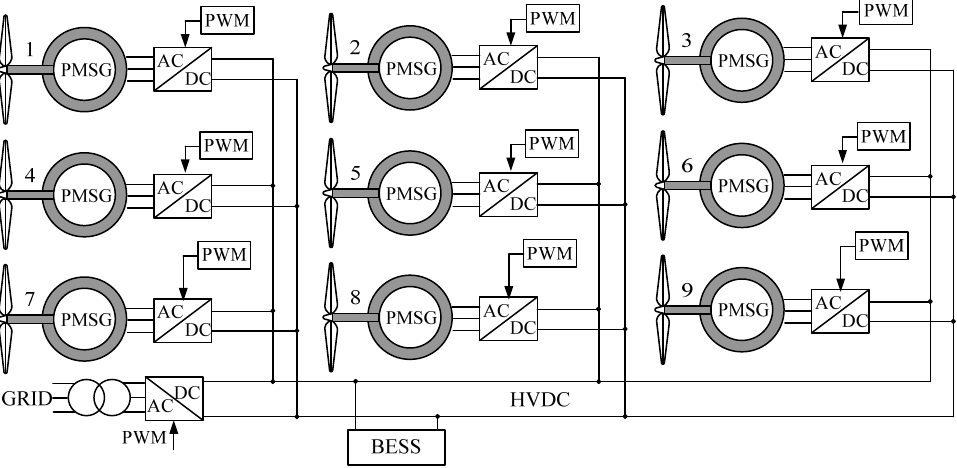
Figure 2. The layout of the wind farm model.